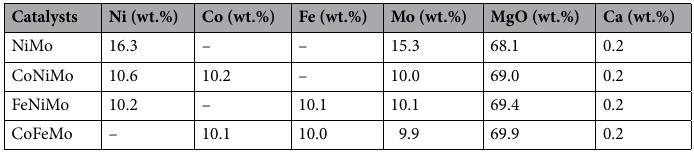
Table 1. Elemental composition of reduced catalysts analyzed by